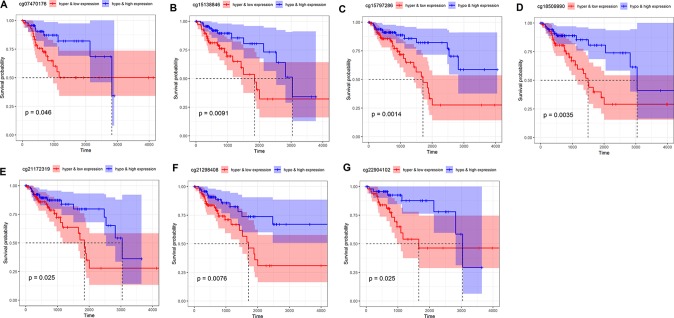
Kaplan–Meier curve of combination of N-acetyltransferase 1 (NAT1) mRNA with CpG sites in COAD. (A) NAT1 mRNA with cg07470176; (B)
NAT1 mRNA with cg15138846; (C)
NAT1 mRNA with cg15797286; (D)
NAT1 mRNA with cg18509990; (E)
NAT1 mRNA with cg21172319; (F)
NAT1 mRNA with cg21298408; (G)
NAT1 mRNA with cg22904102.